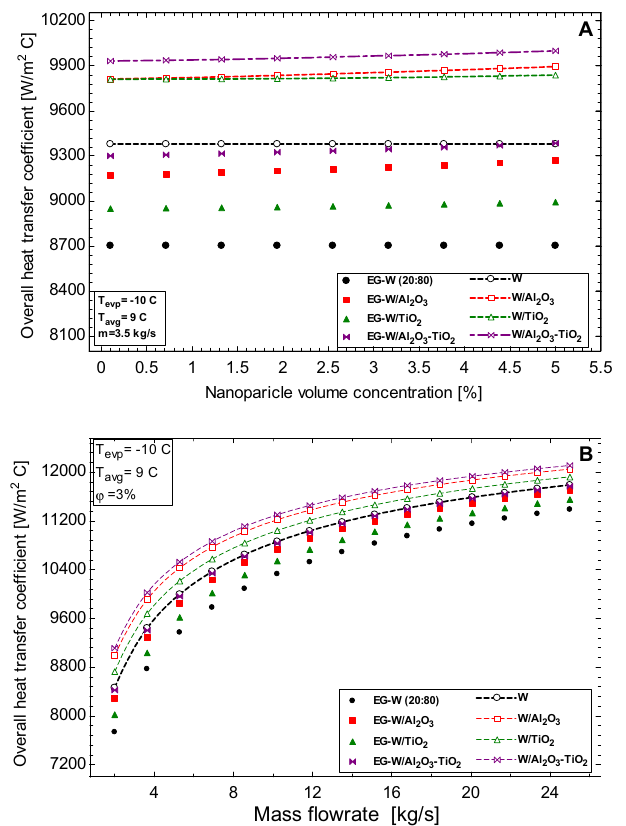
Figure 3. Effect of ( A ) nanoparticle volume concentration and ( B ) mass flowrate on the overall heat transfer coefficient of the fluids inside the